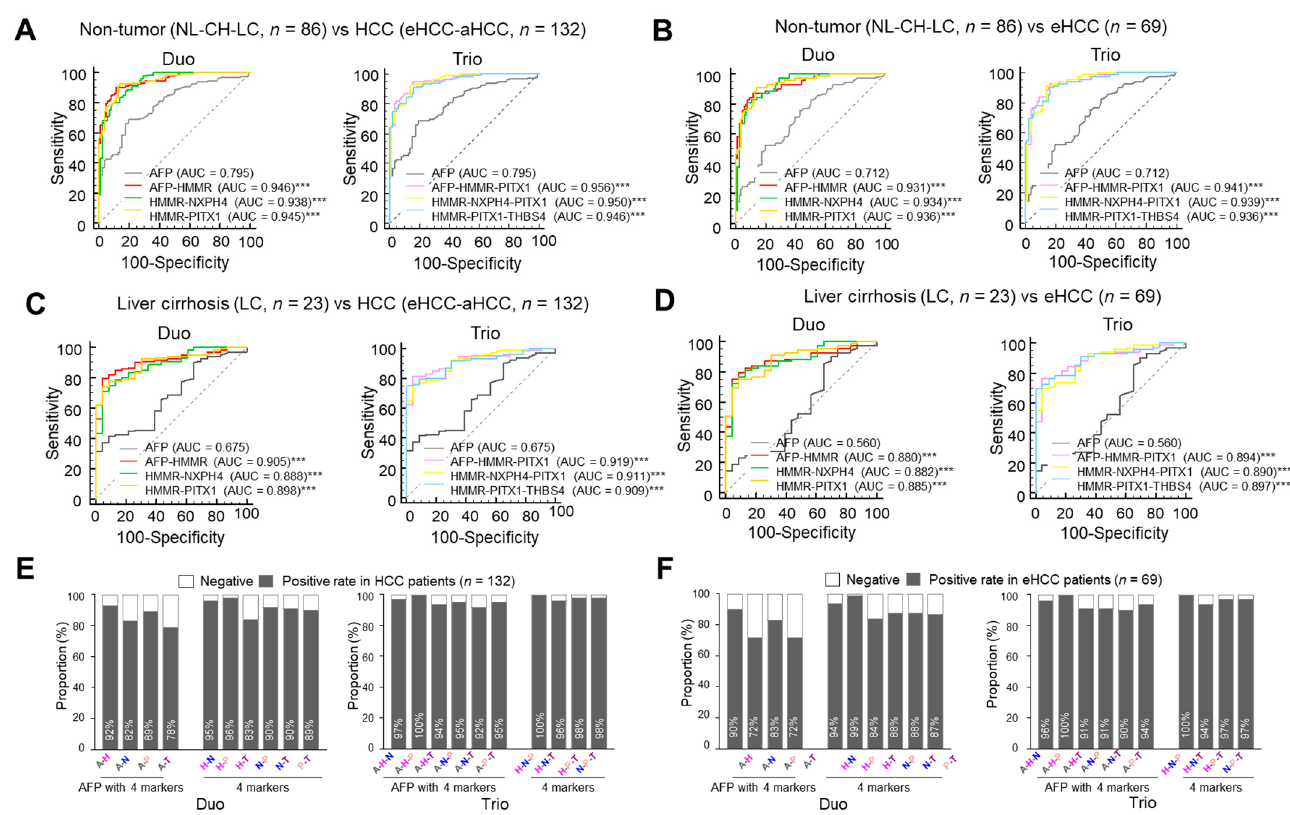
Figure 6. Combinations of AFP with four serum markers for the diagnosis of HCC and early-stage HCC. ( A ) ROC curve of AFP or combination of two markers for patients with all HCC ( n = 132) versus all controls ( n = 86). ROC curve of AFP or combination of three markers for patients with all HCC ( n = 132) versus all controls ( n = 86). ( B ) ROC curve of AFP or combination of two markers for patients with early-stage HCC ( n = 69) versus all controls ( n = 86). ROC curve of AFP or combination of three markers for patients with early-stage HCC ( n = 69) versus all controls ( n = 86). ( C ) ROC curve of AFP or combination of two markers for patients with all HCC ( n = 132) versus liver cirrhosis ( n = 23). ROC curve of AFP or combination of three markers for patients with all HCC ( n = 132) versus liver cirrhosis ( n = 23). ( D ) ROC curve of AFP or combination of two markers for patients with early-stage HCC ( n = 69) versus liver cirrhosis ( n = 23). ROC curve of AFP or combination of three markers for patients with early-stage HCC ( n = 69) versus liver cirrhosis ( n = 23). ( E ) The rate of positive patients for AFP in pairs with new markers or pairs of new markers in all patients with HCC. The rate of positive patients for triplet combinations of AFP with new markers or triplets of the new markers in all patients with HCC. ( F ) The rate of positive patients for pairs of AFP with new markers or pairs of new markers in patients with early-stage HCC. The rate of positive patients for triplet combinations of AFP with new markers, or new marker triplets in patients with early-stage HCC. p < 0.001